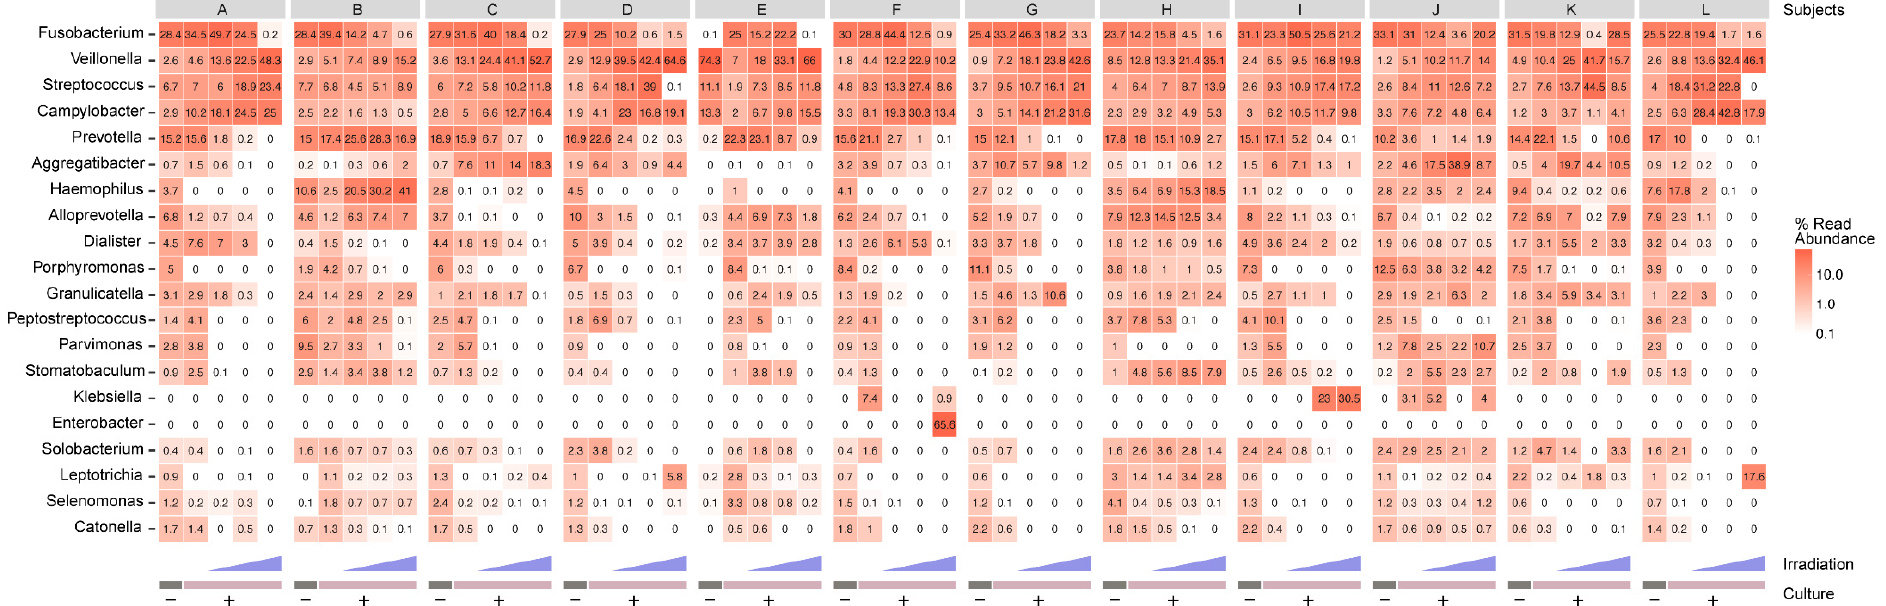
Figure 2. Heatmap illustrating the 20 most abundant bacterial genera after violet LED irradiation and subsequent in vitro cultivation. Values shown in each cell indicate the relative abundance as a percentage, according to sequencing of the V3–V4 region of 16S rRNA gene amplicons. Colors represent the frequency on a log10 scale. The columns are shown in order from left to right for each subject: preculture, 0, 10, 25, 50 J/cm 2 after incubation.